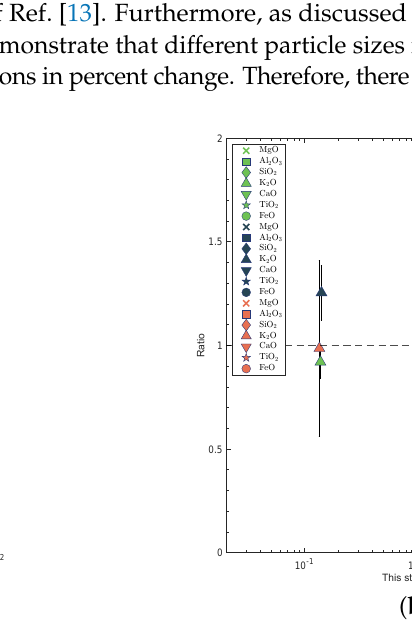
Figure 11. ( a ) Comparison plot for soil sample LS1 mean . ( b ) Comparison plot for soil sample LS2. These comparison plots are shown for validation purposes. The horizontal axis represents the chemical compositions of soil samples in wt.% (This study, see Table 9). The vertical axis shows the ratios of our results to those of Refs. [2,3,13]. The green color indicates the comparisons between this study and Ref. [2], the navy blue color indicates comparisons with Ref. [3], and the orange color indicates comparisons with Ref. [13]. For the sake of readability, the denotations marked in navy blue and orange colors are slightly shifted laterally, while the denotations marked in green color remain in the same